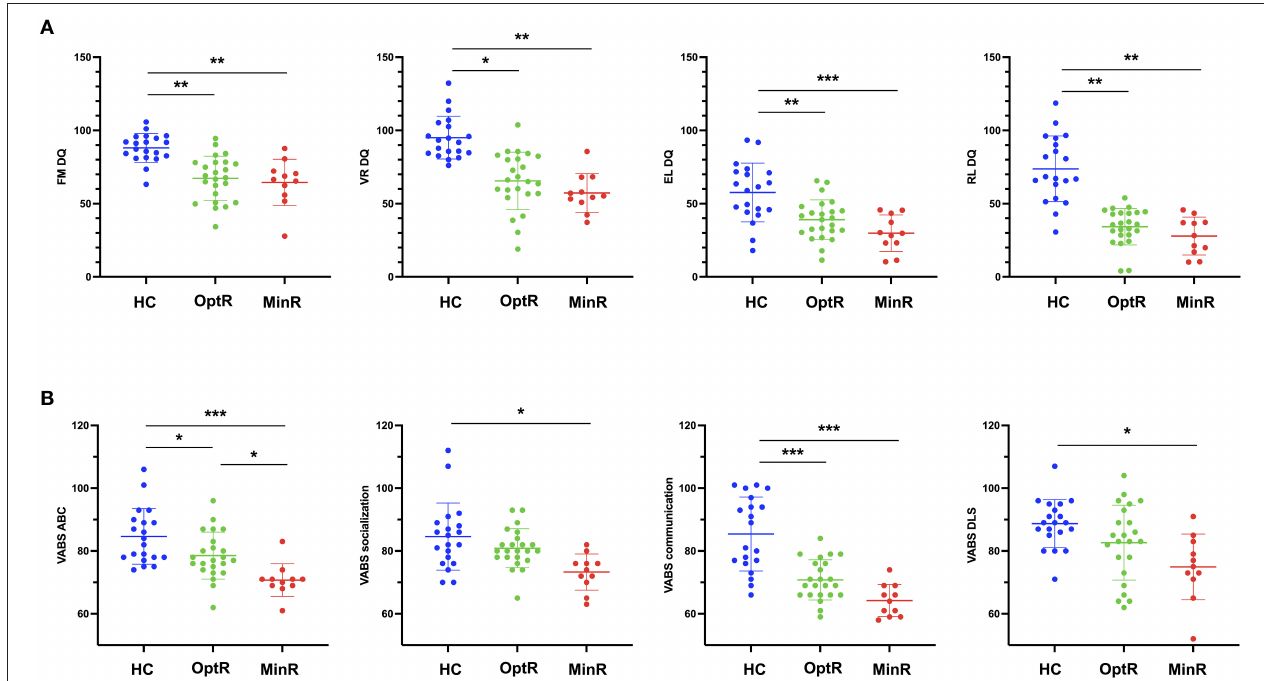
FIGURE 2 | (A) Statistically significant differences in DQ subdomains between subgroups at baseline. (B) Statistically significant differences in VABS-II ABC and VABS-II subdomains between subgroups at baseline. * p < 0.05, ** p < 0.01, *** p < 0.001. ABC, Adaptive behavior composite; DQ, Developmental quotient; EL, Expressive language; FM, Fine motor; HC, Higher cognitive; MinR, Minimal responders; OptR, Optimal responders; RL, Receptive language; VABS-II, Vineland adaptive behavior scale; VR, Visual reception.